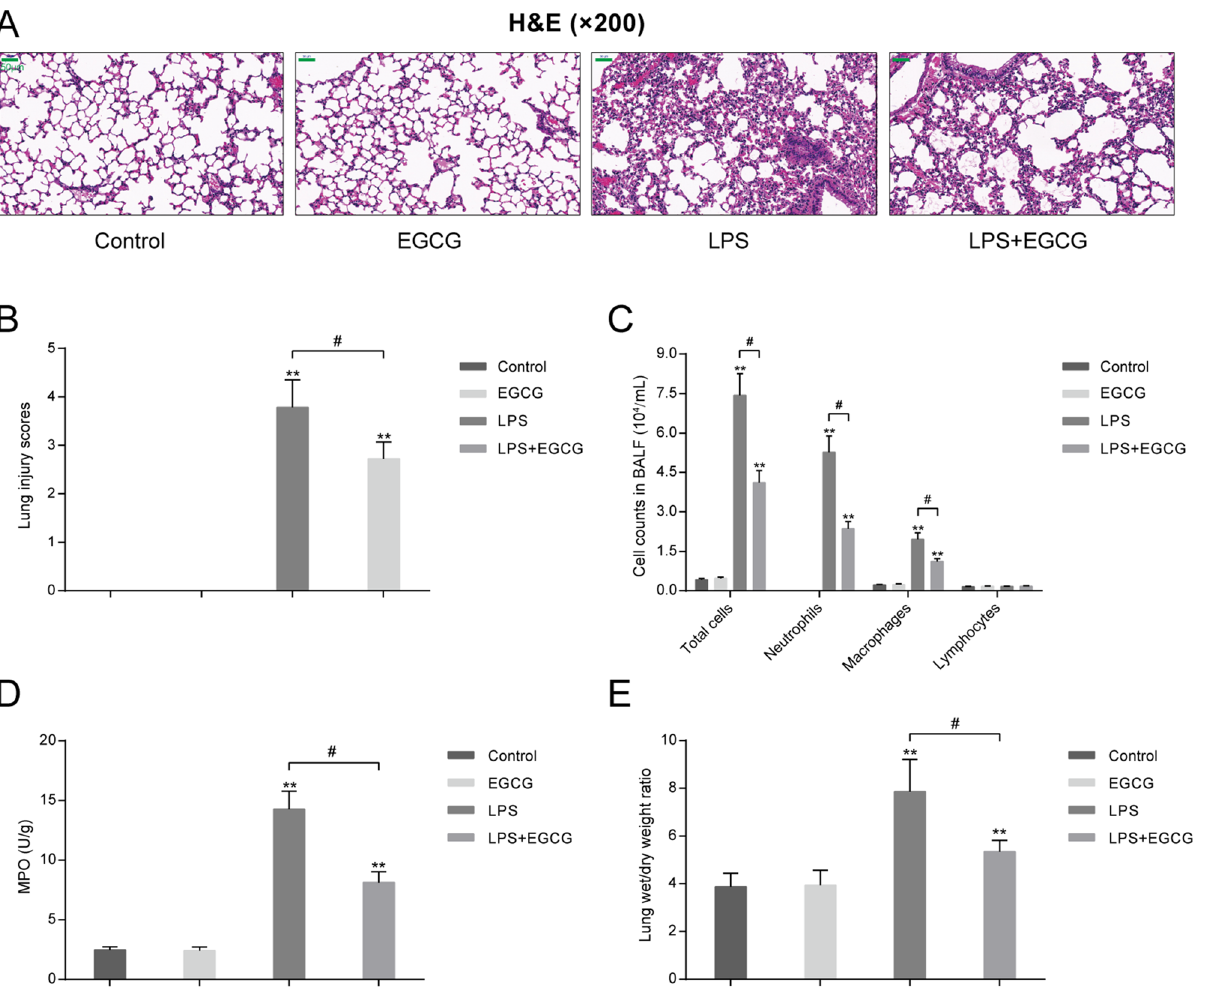
Figure 1. Epigallocatechin gallate (EGCG) alleviates LPS-induced acute lung injury (ALI) in mouse model. Mice were randomly divided into four groups: the control group, the EGCG group, the LPS group, and the LPS + EGCG group. Mice in each group were treated accordingly and examined for ( A ) the pathological changes in lung tissues by hematoxylin and eosin (H&E) staining (200 ×). scale bar = 50 μm; ( B ) lung injury scores following the methods reported before; ( C ) bronchoalveolar lavage fluid (BALF) cell numbers including total cells, neutrophils, macrophages and lymphocytes using a hemocytometer and Giemsa staining; ( D ) MPO activity using a spectrophotometer; ( E ) lung wet/dry weight ration. ** P < 0.01 compared to Control group; # P < 0.05 compared to LPS